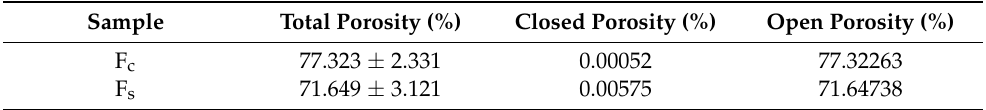
Figure 6. µ -CT images of cellulose aerogel F c ( a ) and F s ( b ) in 3 different planes (X-Z, X-Y, Z-Y) with their 3D computed structure. The color bar shows the intensity of the X-ray absorbed by the fiber matrix (min: black and max: white). Scare bar length is 150 µ m in all images. Table 3. The porosity analysis of F c and F s obtained by µ -CT assessment using 3D analysis in CTAn